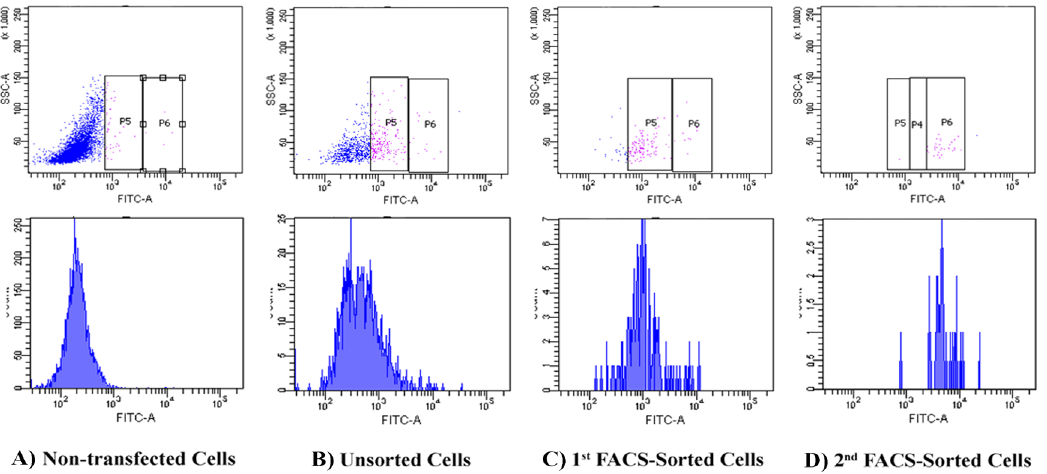
FIGURE 4 - Fluorescence-Activated Cell Sorting (FACS) analysis. (A) Non-transfected CHO cells as negative control. (B) Transfected CHO cells, which have not been sorted by the FACS technique. (C) Transfected CHO cells, which have been first- sorted by the FACS technique. (D) Transfected CHO cells, which have been second-sorted by the FACS technique.